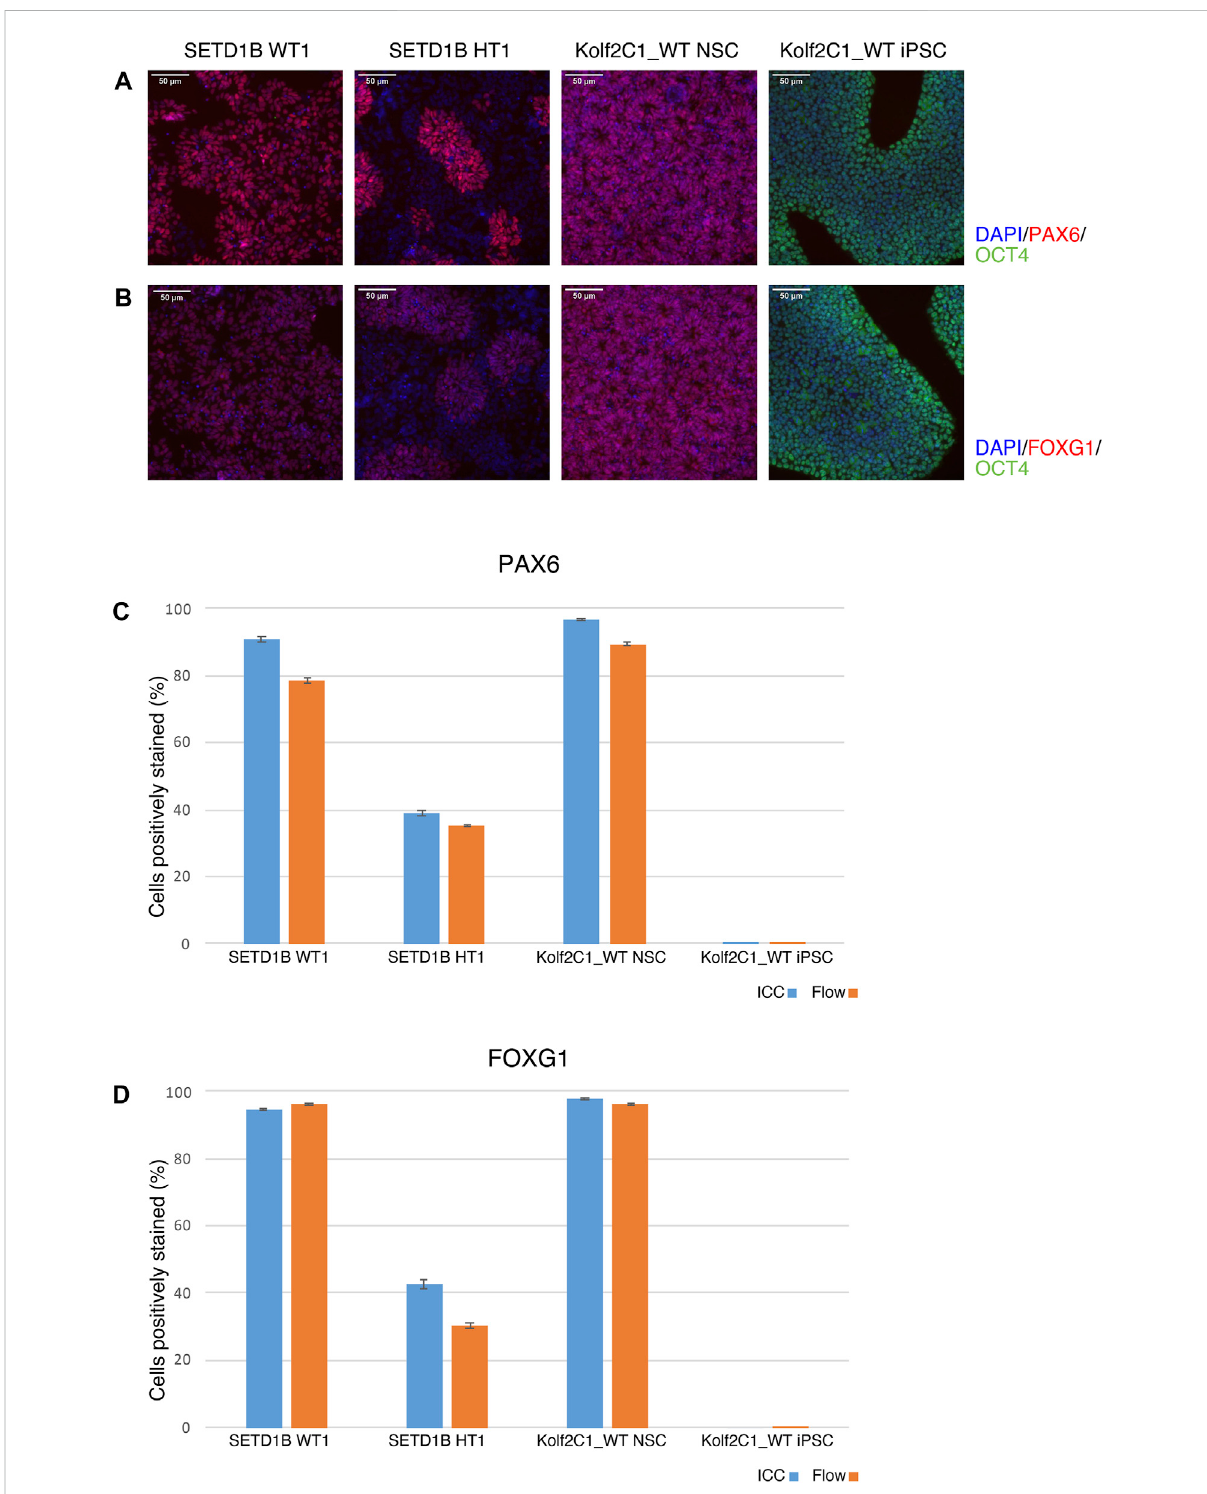
FIGURE 8 Immunocytochemistry (ICC) concordance with fl ow cytometry. Two cell lines from the SETD1B gene set (SETD1B WT1 and SETD1B HT1), and theparental Kolf2C1_WT NSCsand iPSCs were thawed and simultaneouslyseeded ona6-well platefor fl ow cytometry, and a96-well platefor ICC. (A,B) RepresentativecompositeICCimagesforPAX6andOCT4expression (A) ,andFOXG1andOCT4expression (B) . (C,D) Quanti fi cationofsamples using the Cellomics Arrayscan (ICC, blue bars) and fl ow cytometry (orange bars) for PAX6 expression (C) and FOXG1 expression (D) . Scale bars, 50 μ m (20x). Error bars denote ±